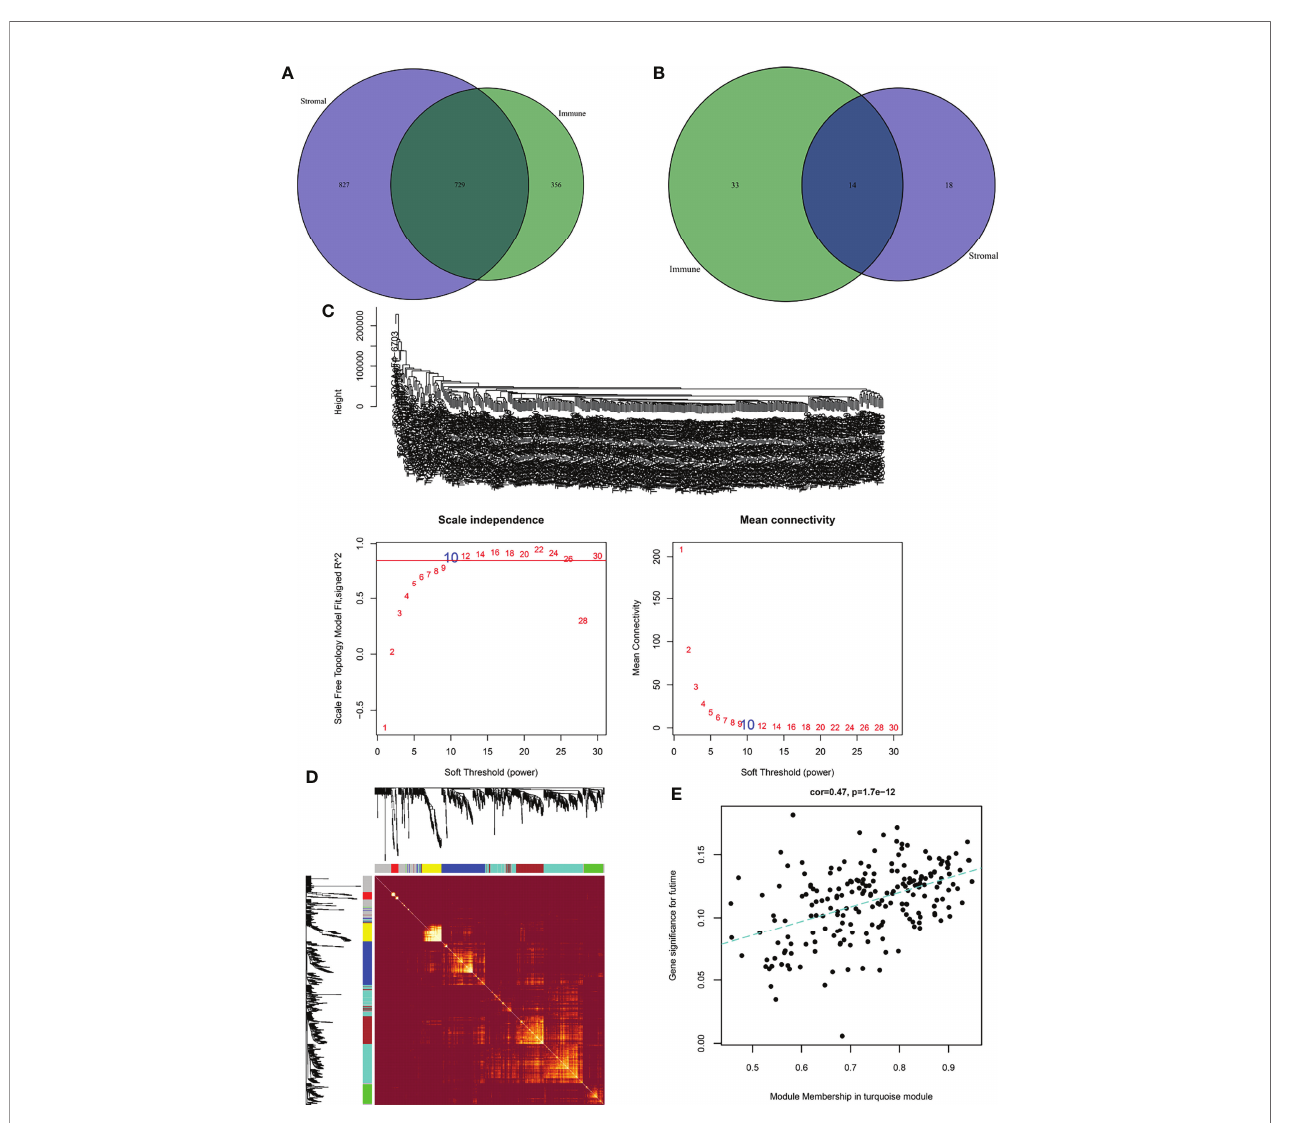
FIGURE 3 | Identi fi cation of immune-related prognostic genes. (A) Upregulated genes between stromal and immune scores. (B) Downregulated genes between stromal and immune scores. (C) The upper fi gure shows the sample clustering result to determine whether there were outliers. The left fi gure is the soft threshold result, where the horizontal axis is the soft threshold (power), the vertical axis is the evaluation parameter of the scale-free network, and the soft threshold result is 10. The right fi gure shows the soft threshold and average connectivity. (D) TOM network heatmap of upregulated and downregulated genes. (E) Scatter plot of module eigengenes in the turquoise